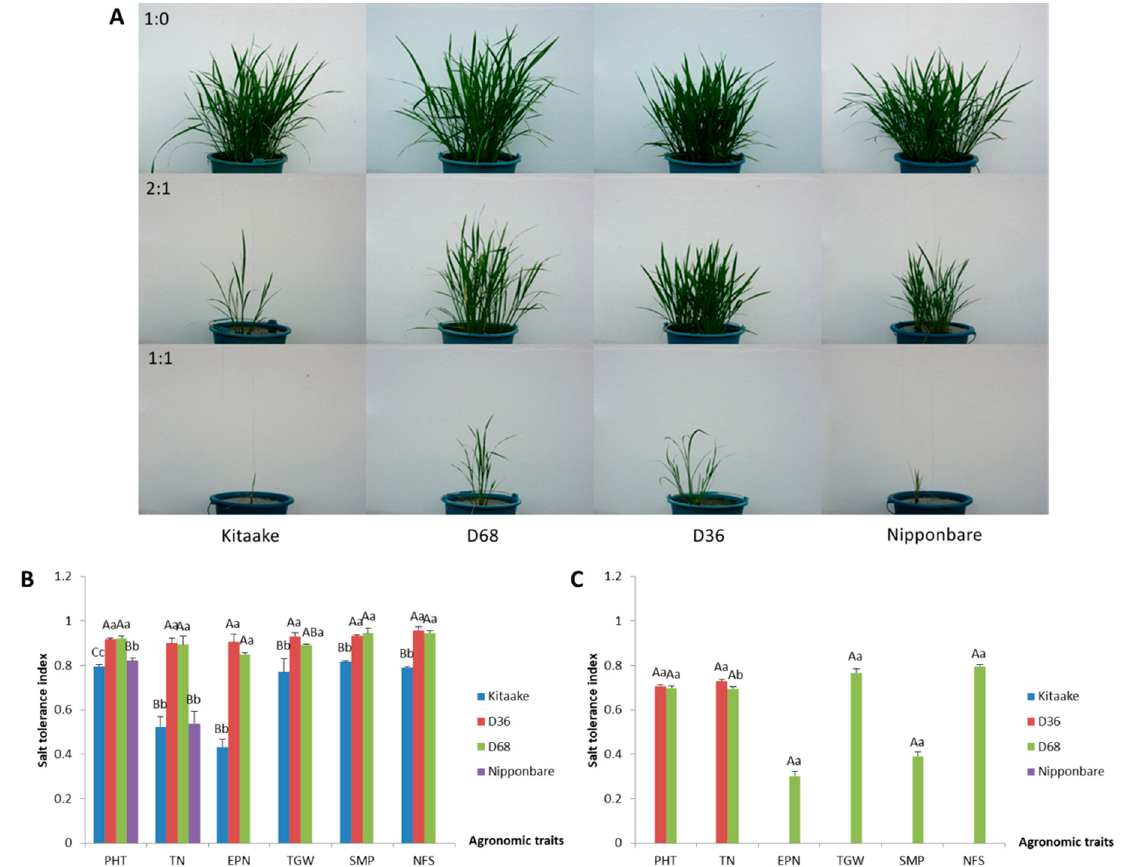
Figure 1. Pot experiment in 2013. ( A ) Four rice variety plants’ performance in three kinds of potting mixture after 50 days from transplantation. The relative parameters (salt tolerance index) of growth and yield components of the four rice varieties in the ( B ) 2:1 potting mixture ( C ) 1:1 mixture. PHT represents plant height (cm), TN represents the number of tillers per plant, EPN represents the effective panicle number per plant, TGW represents the 1000-grain weight (g), SMP represents the spikelets of the main panicle, and NFS represents the number of filled spikelets. Values are means ± SD, n = 3. Different capital letters (A, B) and lowercase letters (a, b) on columns indicate significant differences at p < 0.01 and p < 0.05 based on Duncan’s test.